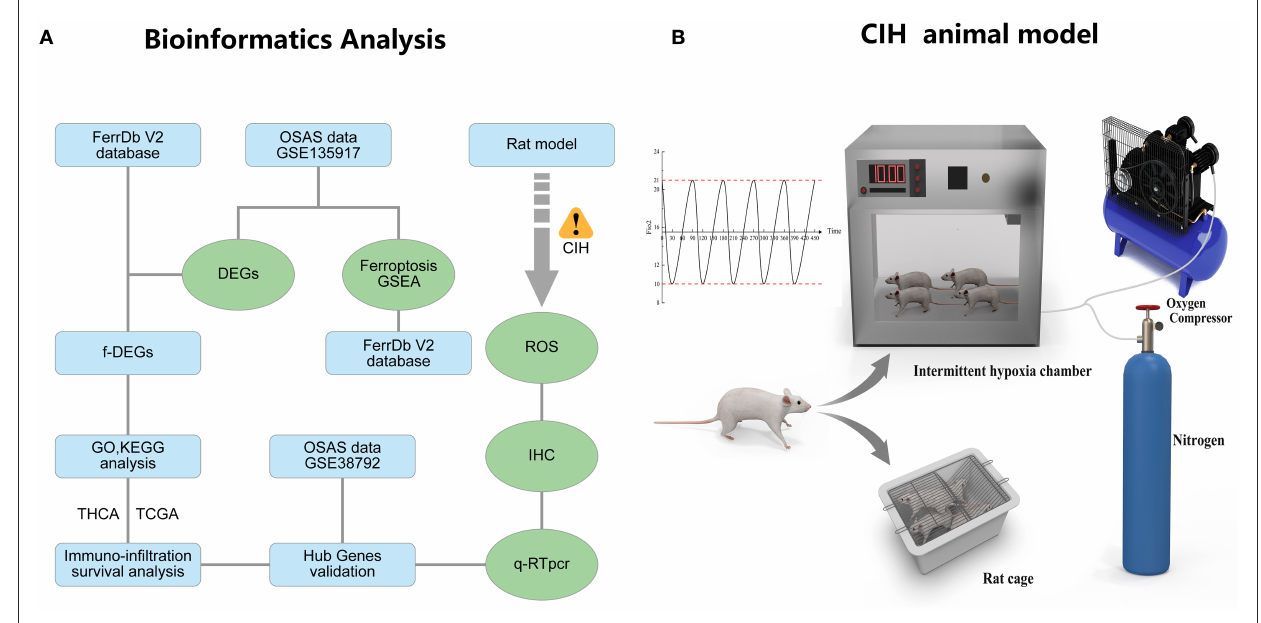
FIGURE1 The research flowcharts and animal models. (A) Flowchart of bioinformatics analysis and experimental validation. (B) The experimental model of chronic intermittent hypoxia in rats.